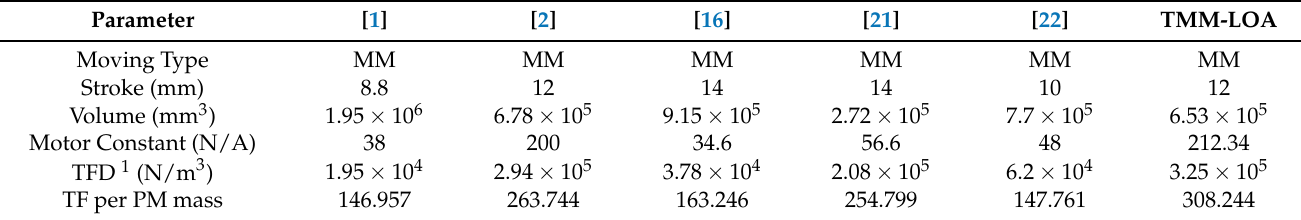
Table 2. Comparison of proposed TMM-LOA with different LOA